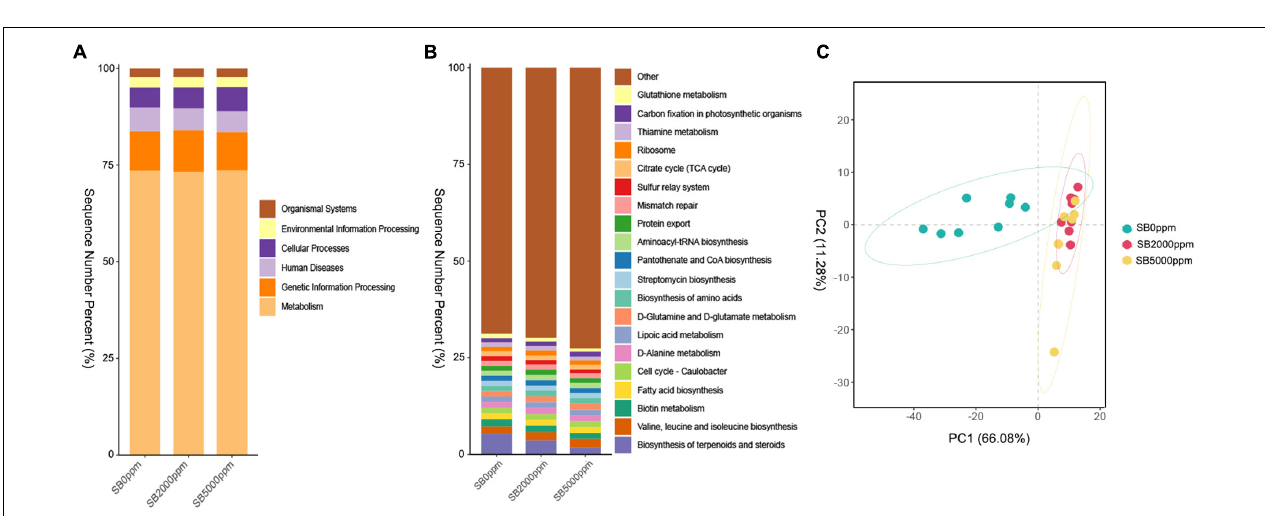
FIGURE 6 | Function prediction of commensal microbiota of Wolbachia -excluded data. (A) KEGG pathway at L1 level. (B) KEGG pathway at L3 level. (C) Principal component analysis (PCA) of commensal microbial function at L3